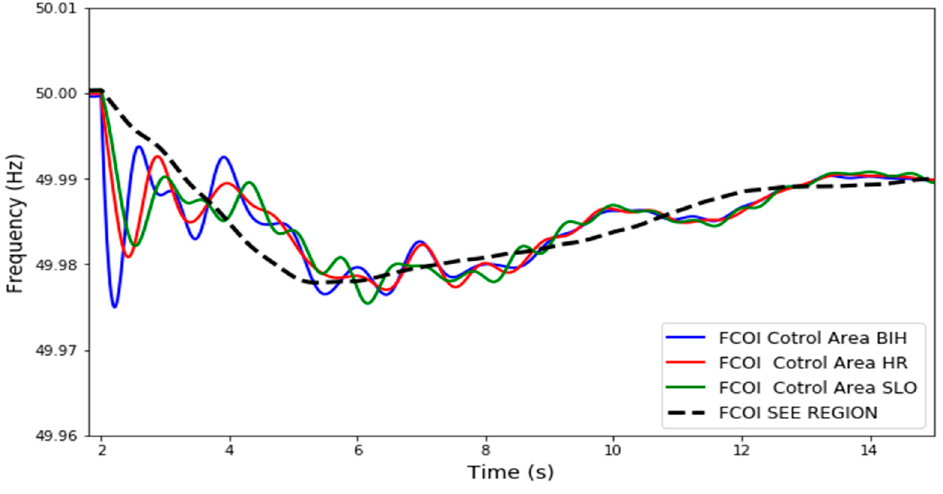
Figure 7. EPS frequency response, simulation time 15 s.